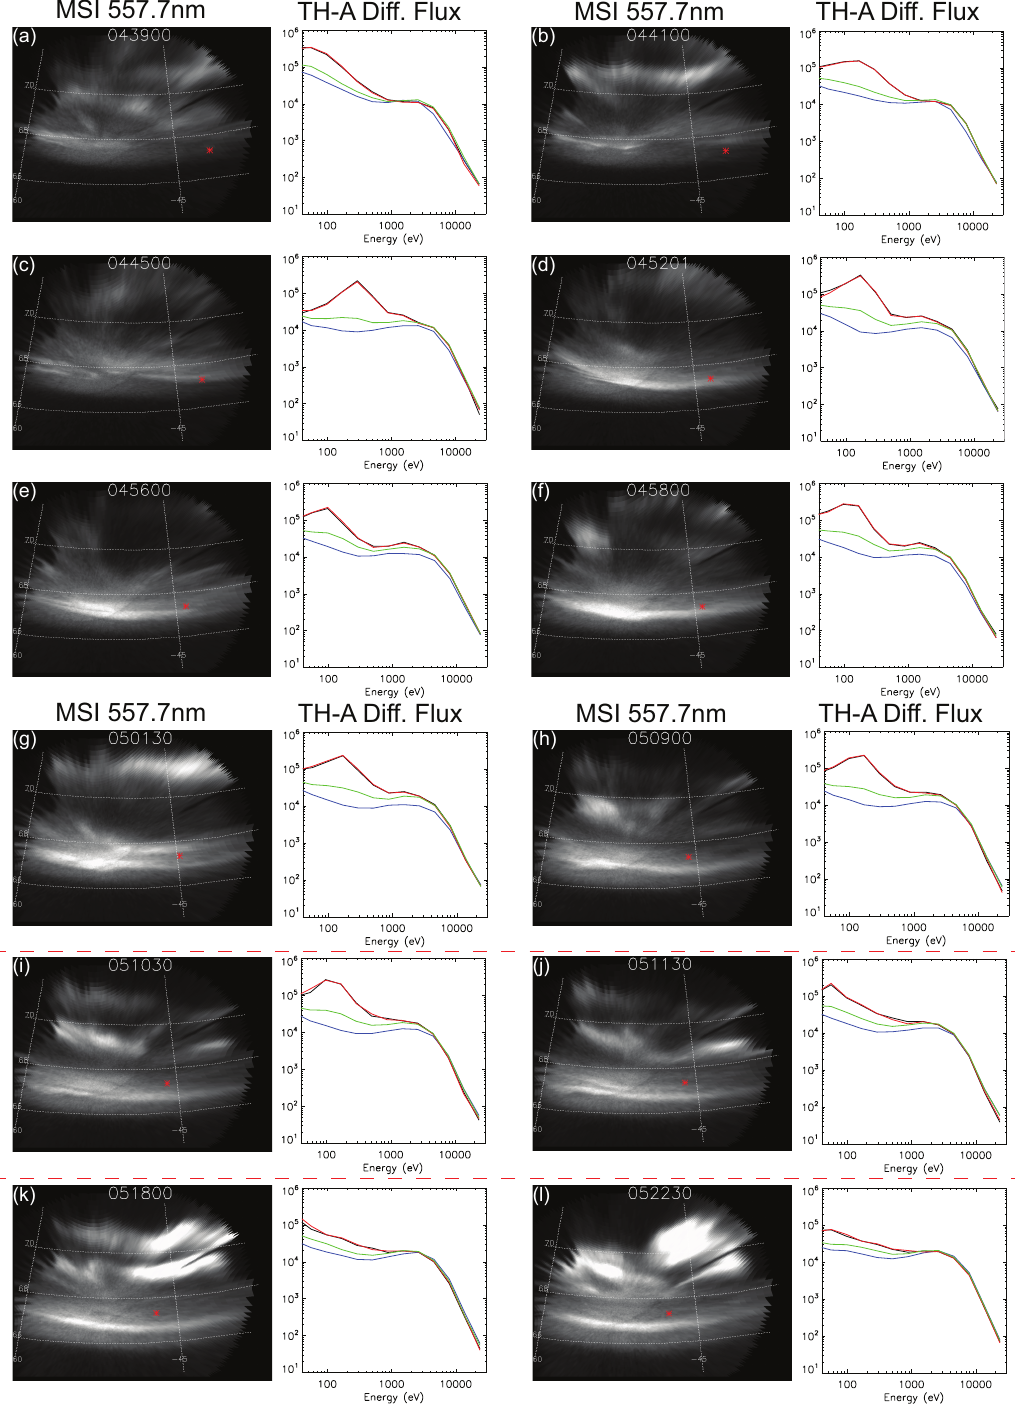
Fig. 7. A few selected images from FSMI MSI 557.7nm observations. The images are converted into AACGM coordinates assuming 110km emission height. The footprint of TH-A, calculated from T02 model, is plotted as a red asterisk in each image. To the right of each image is the correspondent electron number flux spectra observed by TH-A. The color code of the spectra plot is the same as in Fig. 5a. A red dashed box highlights the interval when the probe is traversing the boundary between QPEB and